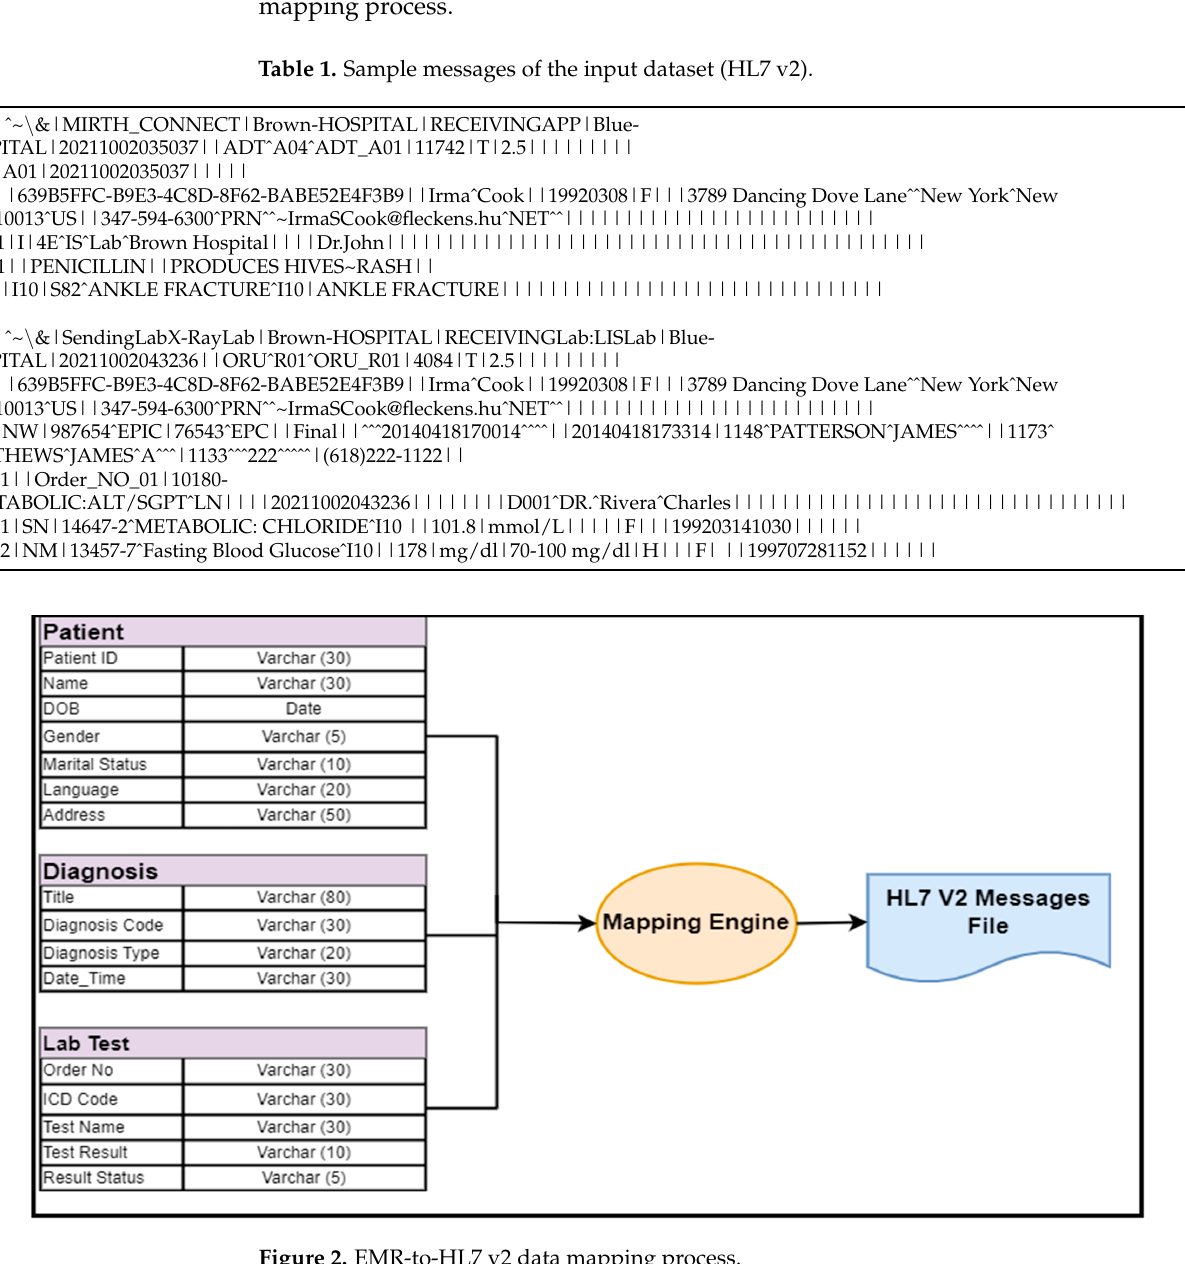
Figure 2. EMR-to-HL7 v2 data mapping process.